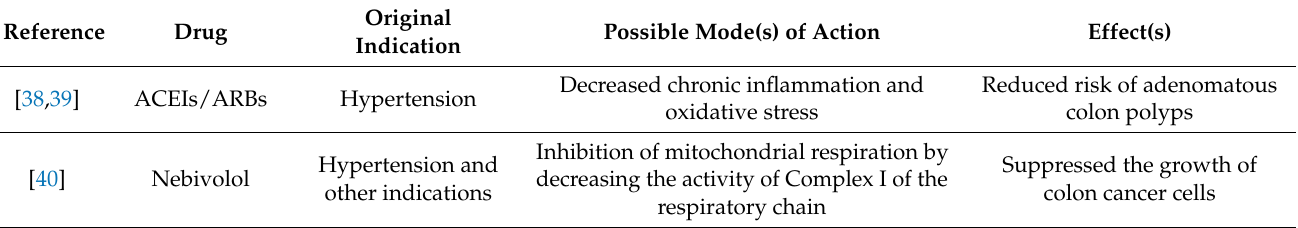
Table 1. Summary table of the drugs that have been repurposed to be used in colon